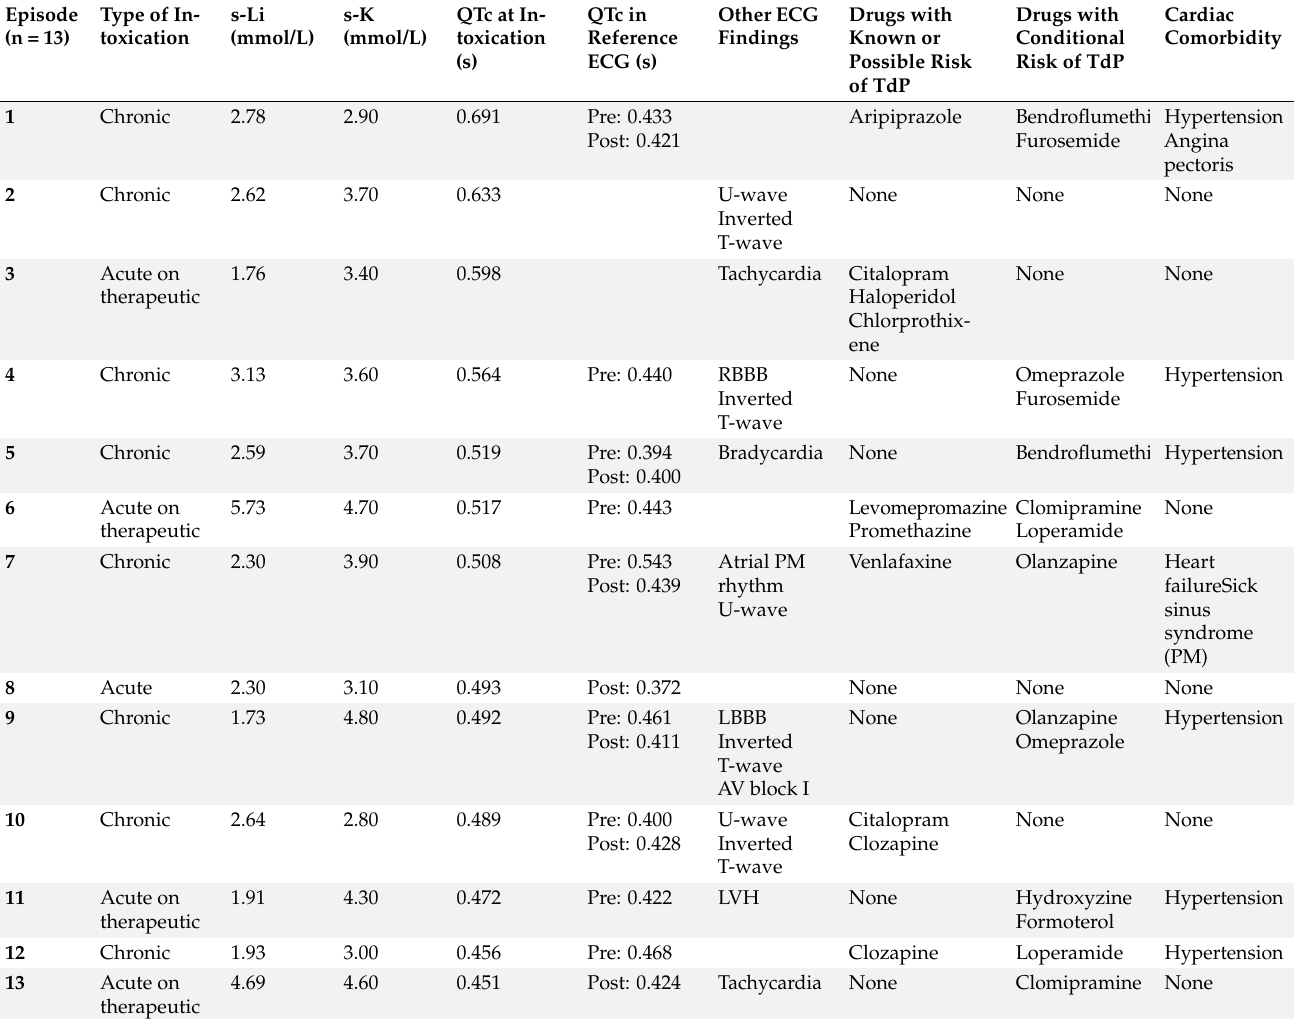
Table 5. Episodes of lithium intoxication with QT prolongation.